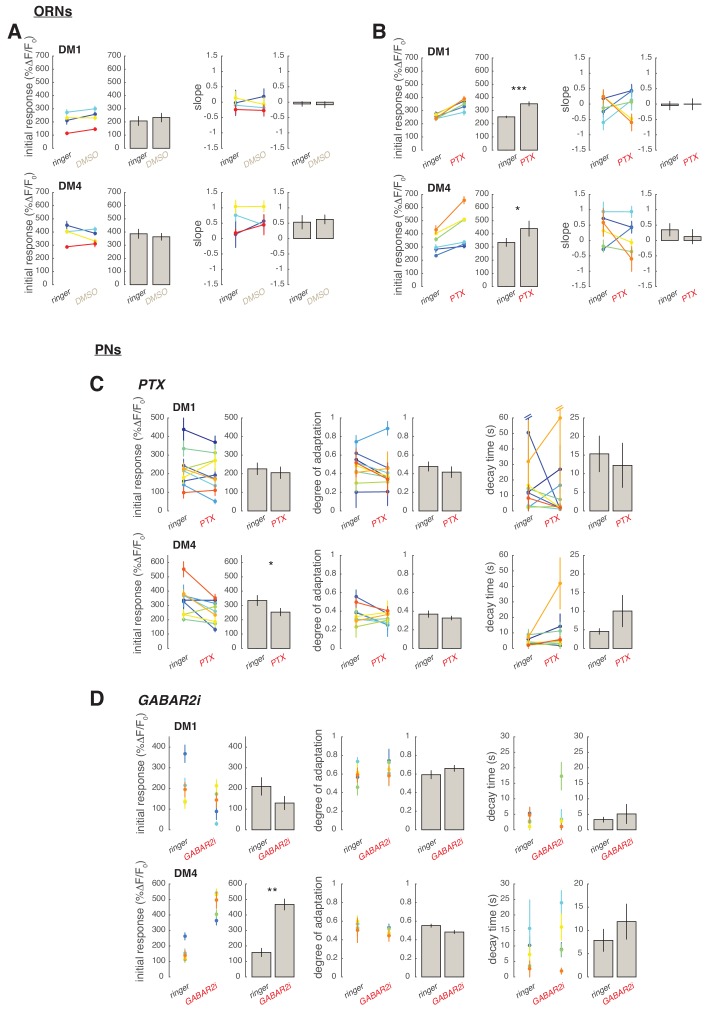
Single trials from GABA experiments.The calcium signal within glomerulus DM1 and DM4 in response to the 2 minutes fluctuating stimulus was quantified in individual flies. As in main Figure 4, the maximum response to each individual odor pulses within the random pulse sequence was calculated. In ORNs the maximum response as a function of time, rmt, was then fitted by a linear function: rmt=r0+bt, where r0 indicates the initial response and b the slope of a linear trend in the response amplitude. In PNs rmt was fitted by an exponential function: rmt=r0(1-d+de-tτ), where d is the degree of adaptation (d=1-f∞f0) and τ the decay timescale of the response. (A) Effect of DMSO on calcium response. Initial response r0 and slope b fitted in single trials (colored dots, error bars indicate 95% confidence intervals) and averaged across trials (gray bars ± SEM, n=4). DMSO has no significant effect on initial response and on a linear trend in the response amplitude over 2 min (paired t-test). (B) Same as (A) for PTX application. PTX significantly increases the initial response of both DM1 and DM4 (paired t-test, *p<0.05, ***p<0.001, n=6). (C) In PNs PTX application slightly decreases DM4 initial response (p<0.05) but has no effect on the degree of adaptation d or on the response decay timescale τ(n=10). Note that in two trials confidence intervals for τ were extremely large suggesting that the exponential function is not a good fit for the data due to a slow superimposed linear trend. Excluding these two data points from the analysis does not affect the results. (D) In PNs expression of GABABR2-RNAi increases the initial response of DM4 (**p<0.01) but has no effect on DM1 (Mann-Whitney U-test). Degree of adaptation and timescale of the response decay are also not affected (n=5).